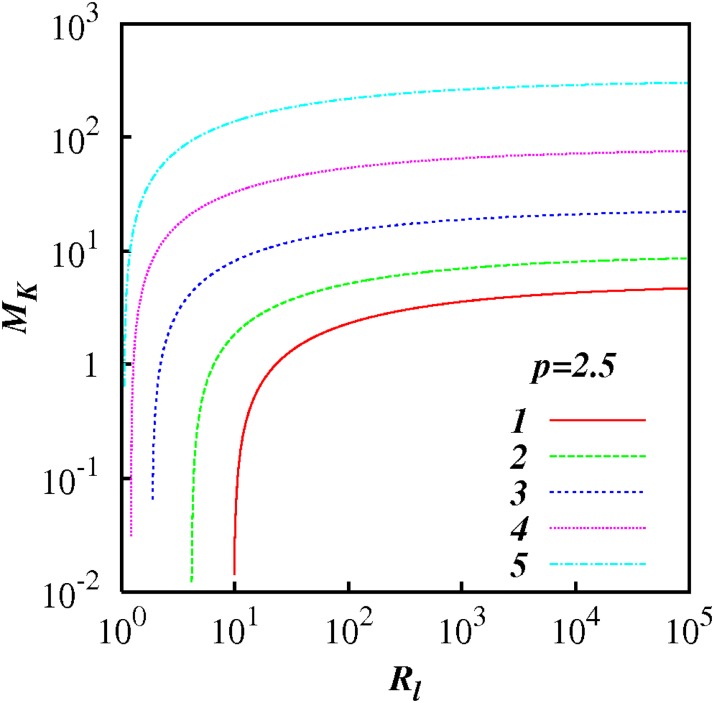
Similar to Fig 7, except for p = 2.5.